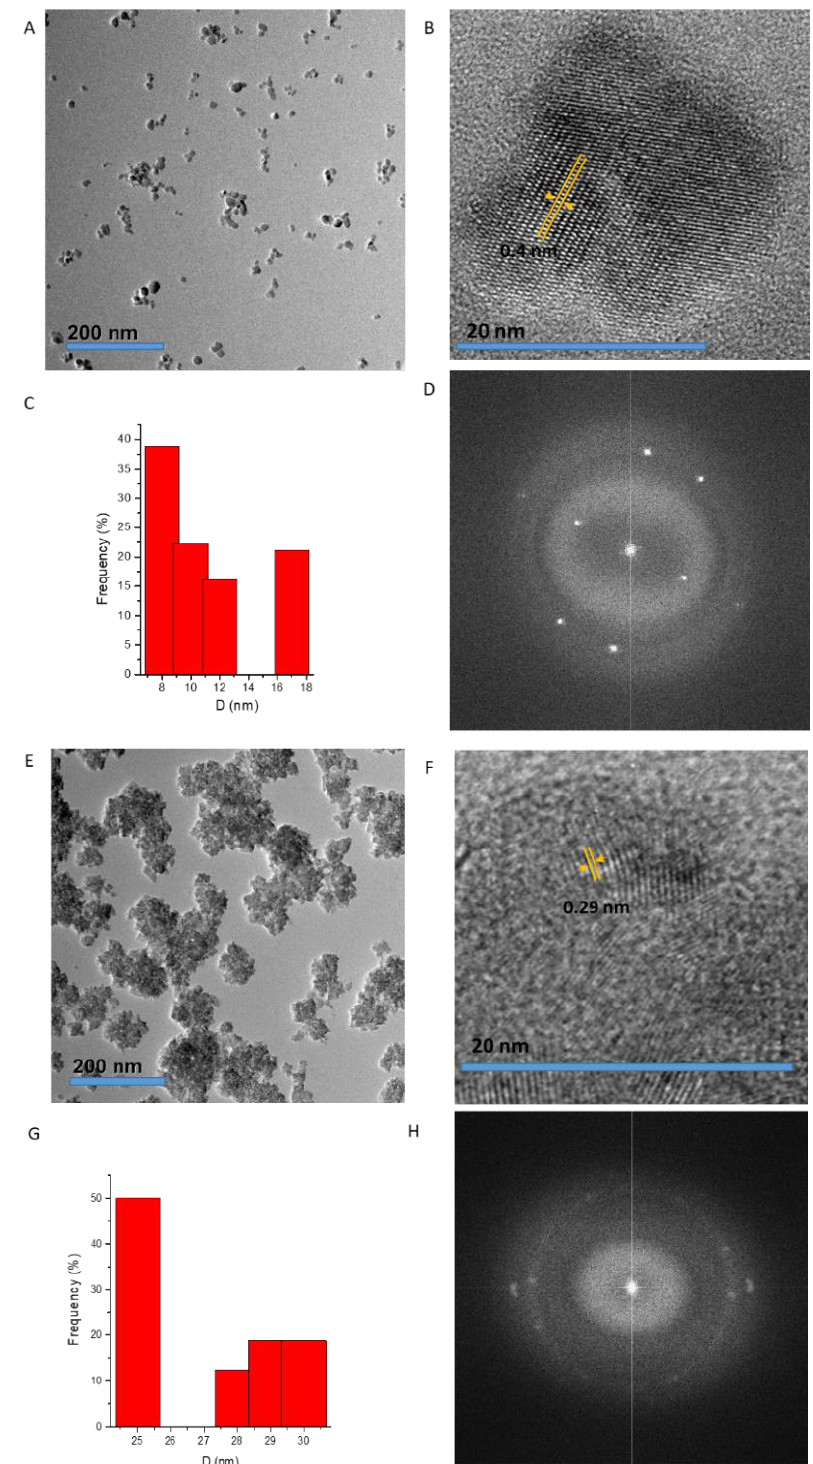
Figure 1. Transmission electron microscopy (TEM), selective area electron diffraction (SAED) and particle size distribution histograms for CF-MNPs ( A – D ) and ZCF-MNPs ( E – H ).